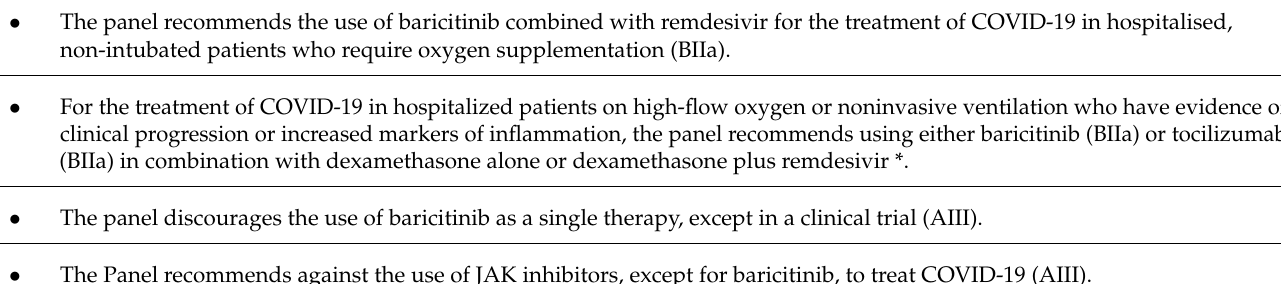
Table 3. Summary of COVID-19 Treatment Guidelines Panel recommendations (modified from the NIH guidelines)